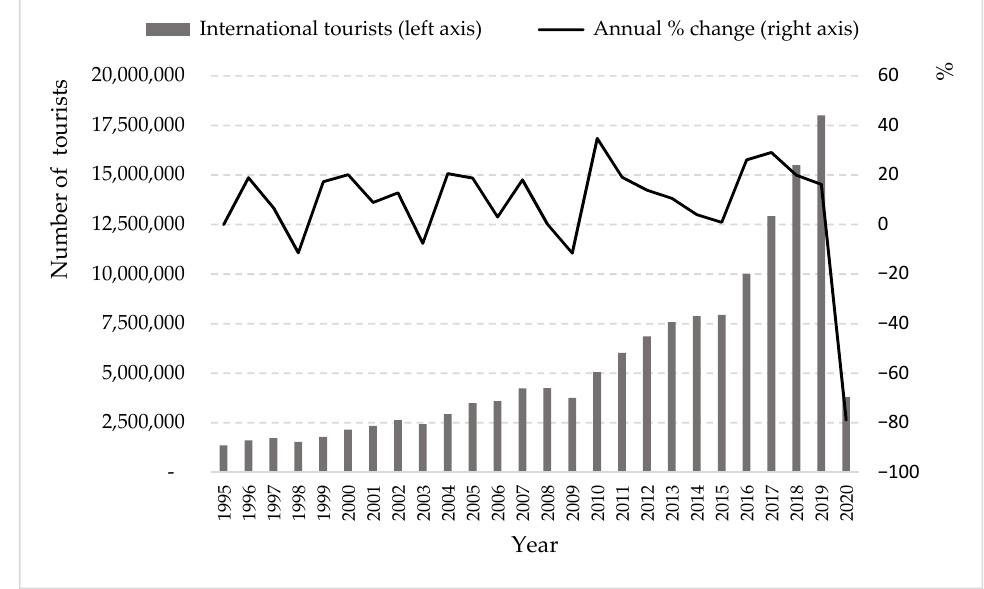
Figure 1. Number of international tourists arrivals to Vietnam and annual changes rate in arrivals (1995–2020). Source: GSO (2020).